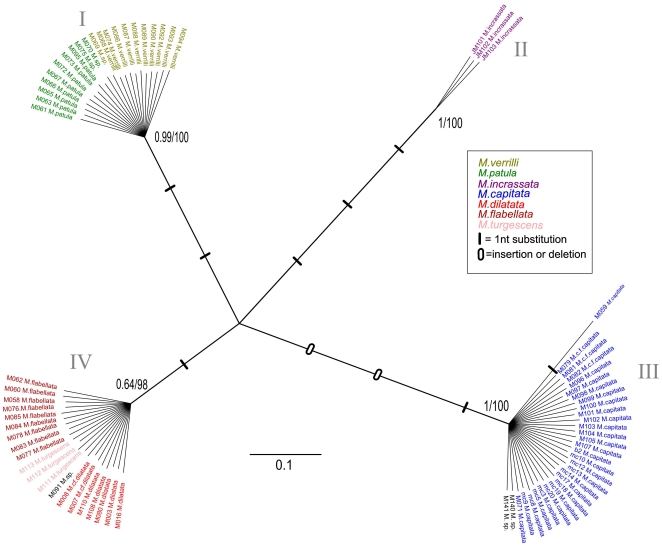
Bayesian inference tree of the mitochondrial control region for Hawaiian specimens.Confidence values are BI/ML, and species are color coded by morphospecies identification.